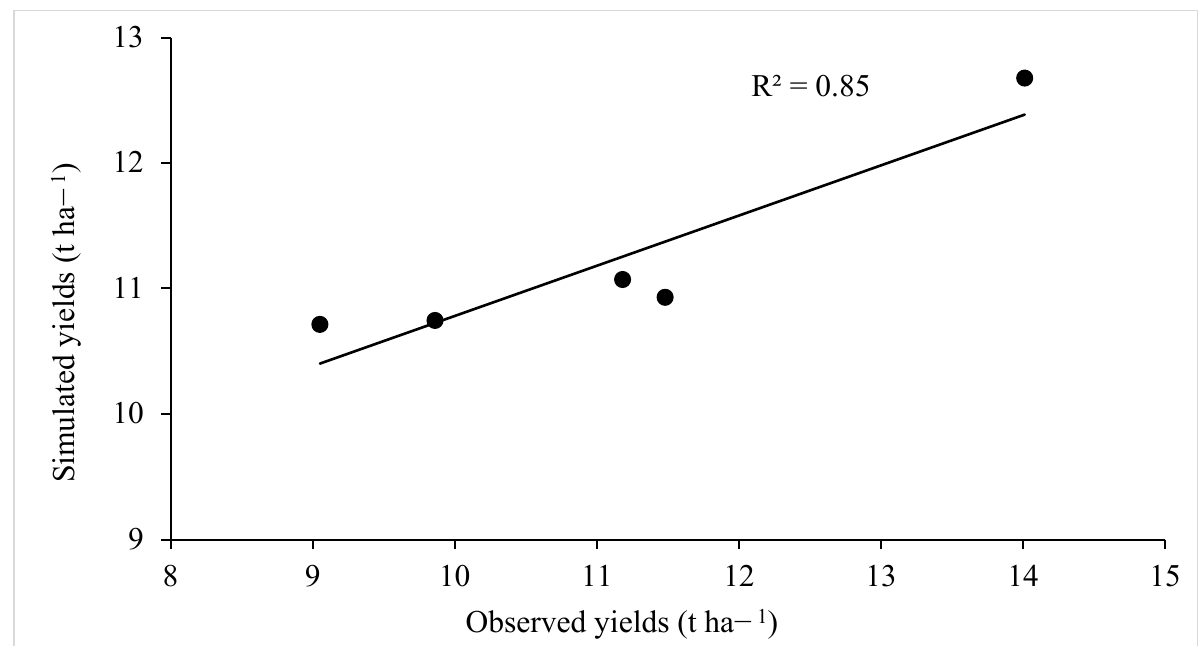
Figure A4. Simulated crop yields (t ha − 1 ) regression result on observed maize yields (figure obtained from [32]).